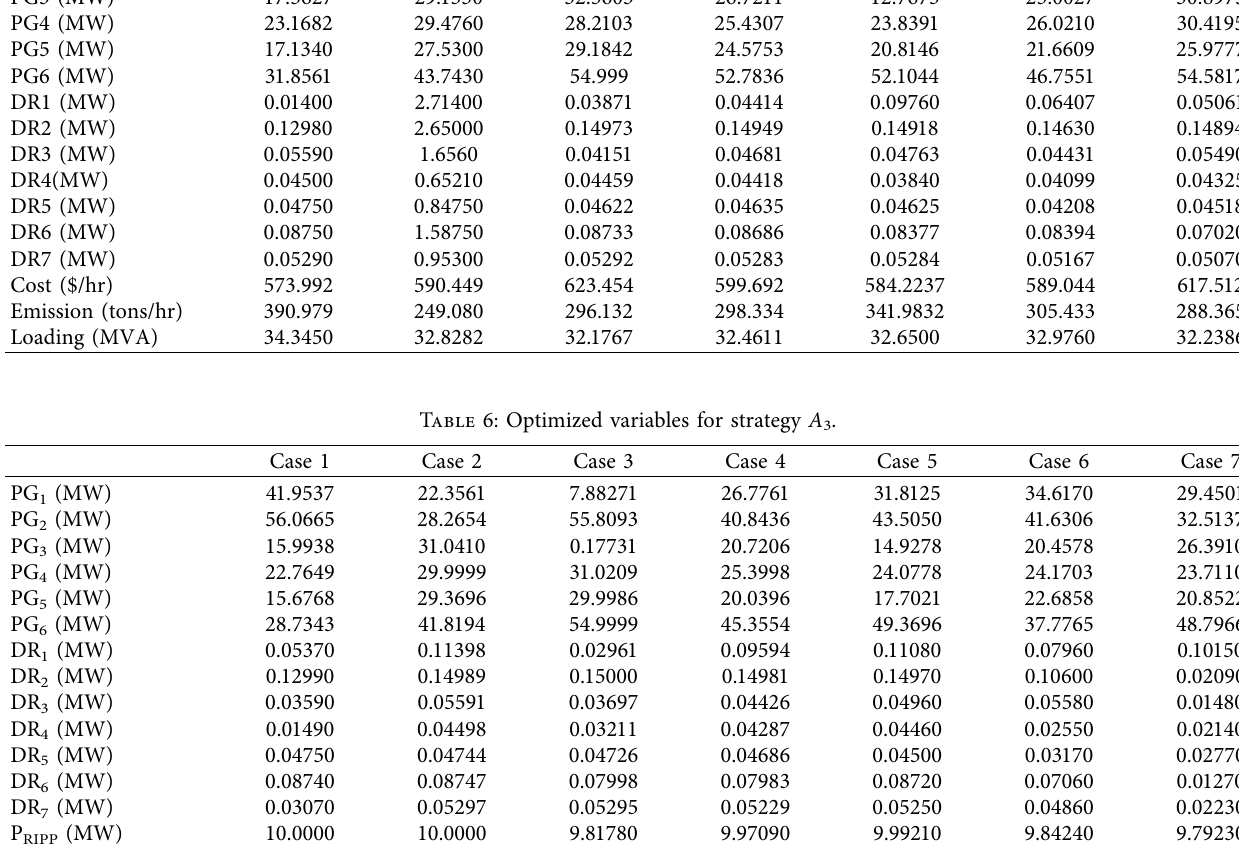
Table 5: Optimized variables for strategy A 2.